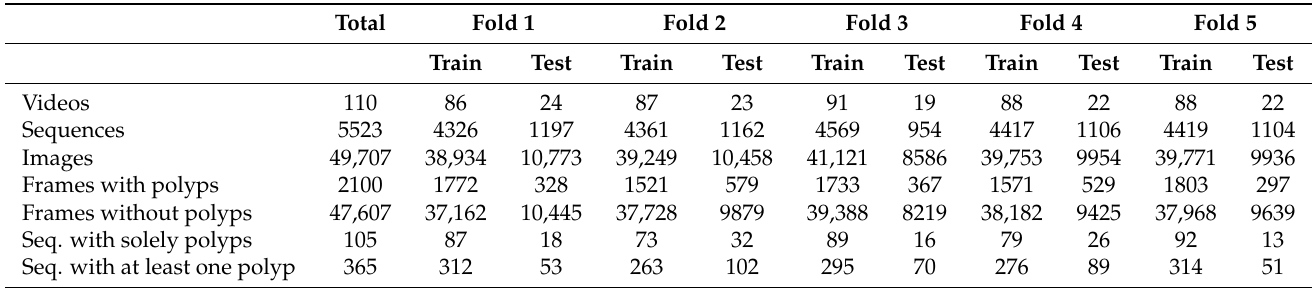
Table 1. Dataset structure and class distribution. Columns starting with Fold indicate the 5 different folds used during evaluation, as proposed in Laiz et al. [2], with their corresponding Train and Test distribution. Here, Seq. is an abbreviation for